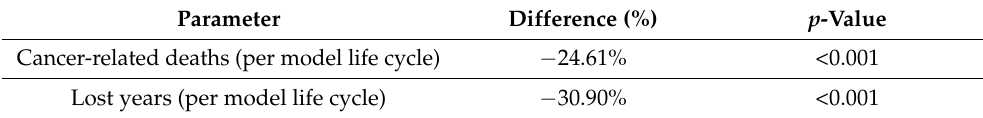
Table 3. Comparison between